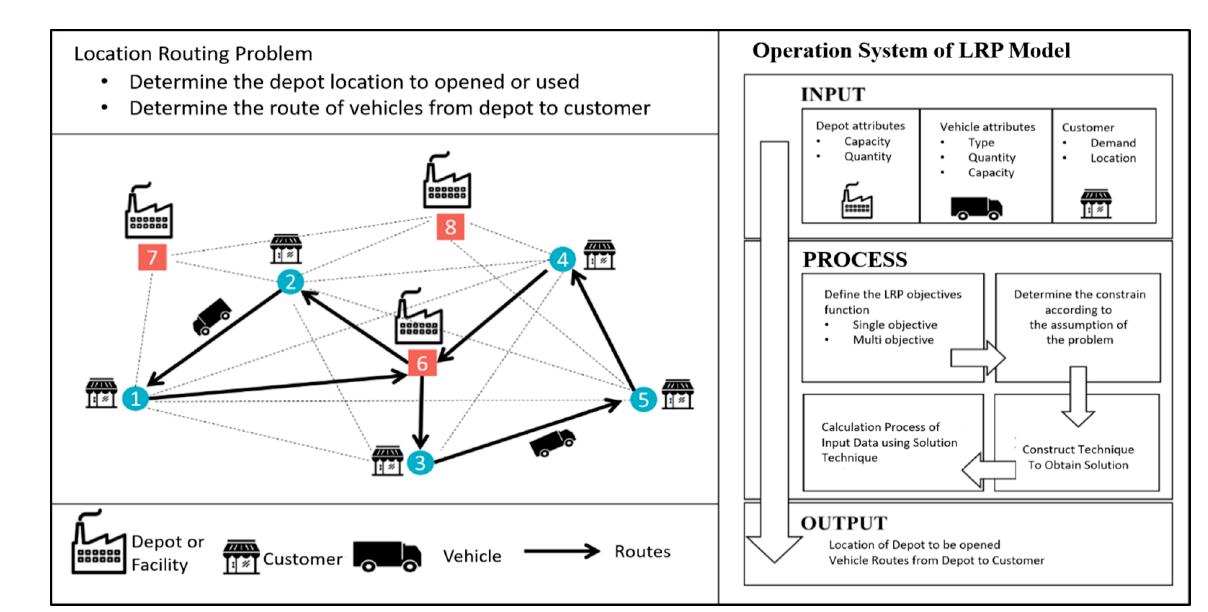
Figure A1. Operation system of the LRP model.